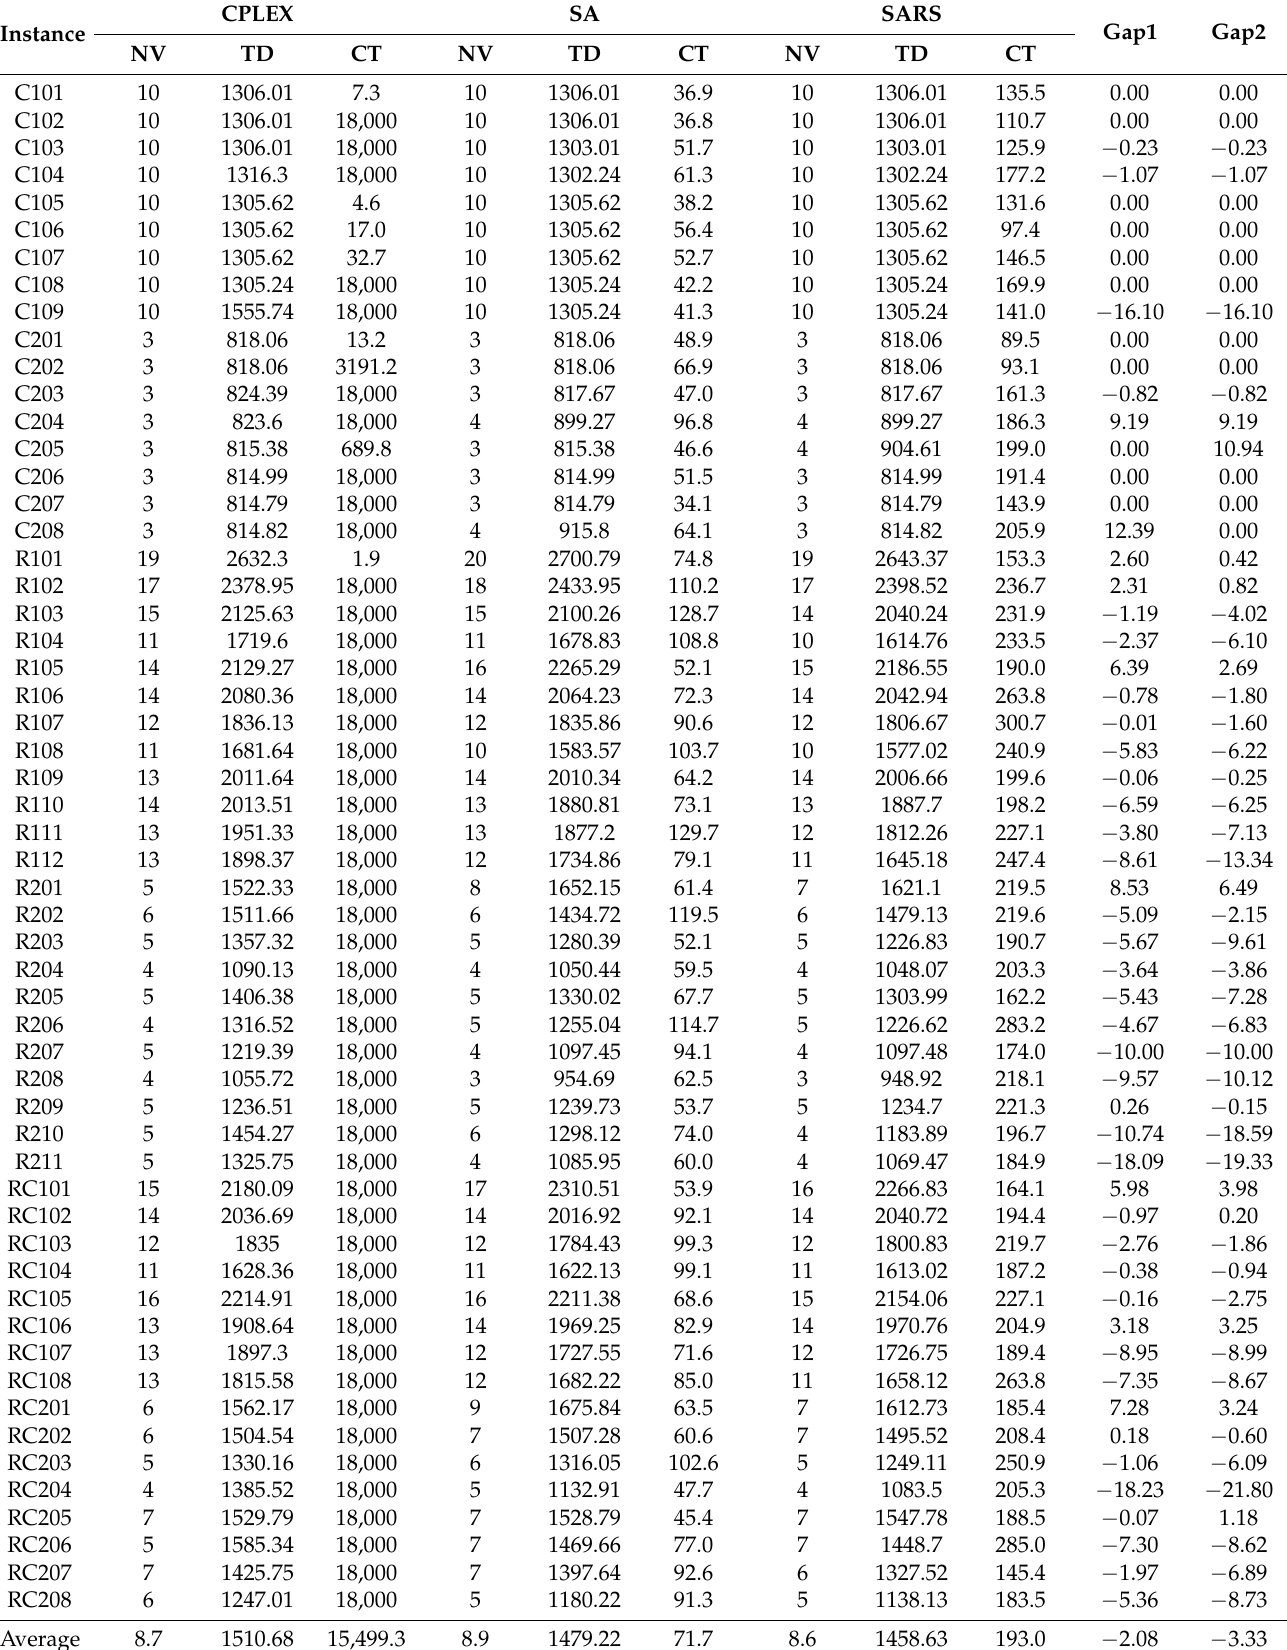
Table 10. Comparison among CPLEX, SA, and SARS on the PCPTW dataset with 100